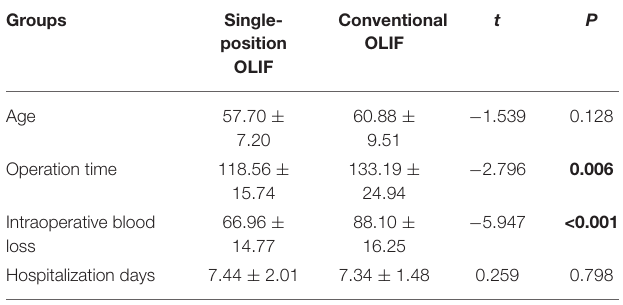
TABLE 3 | Comparison of the ODI and IDH between the two groups preoperatively, postoperatively and at the last follow-up. Time Single-